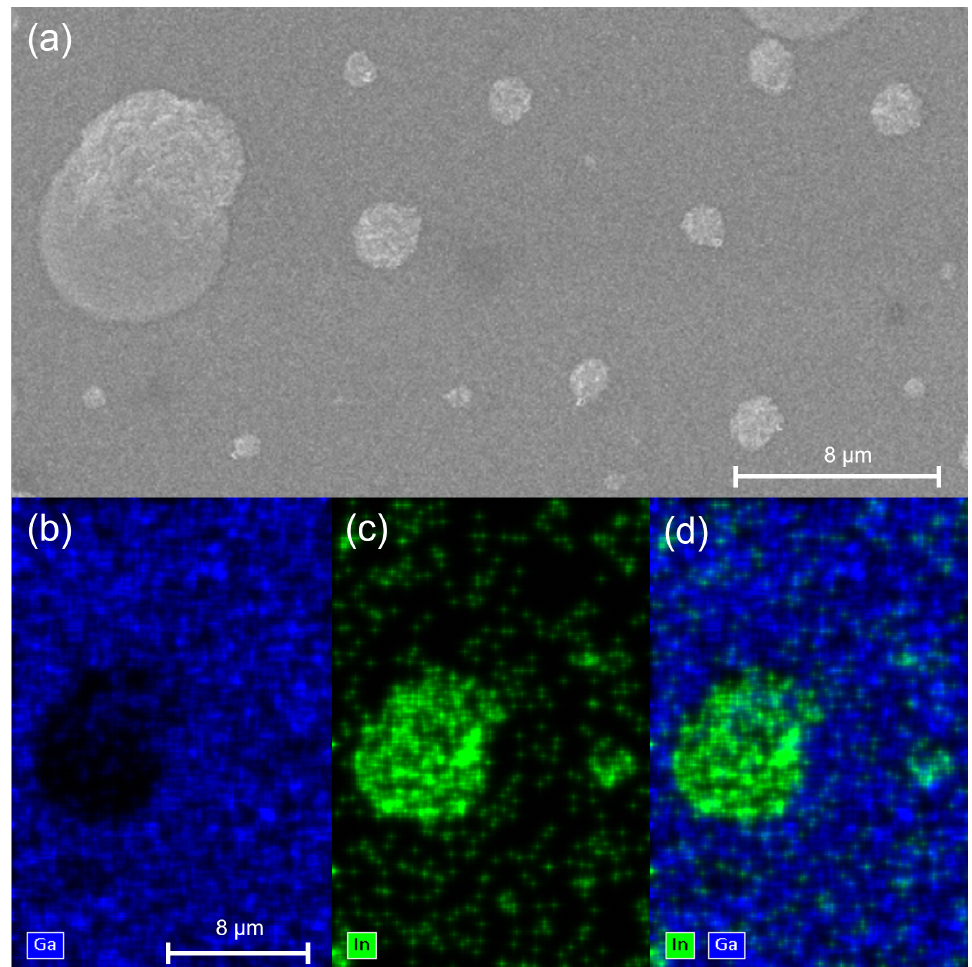
Figure 1. ( a ) SEM image and ( b – d ) EDX analysis of a metal droplet. Here are shown separately Ga ( b ) and In ( c ) compositions and their combination ( d ). As can be seen, the metal droplets are almost entirely made of